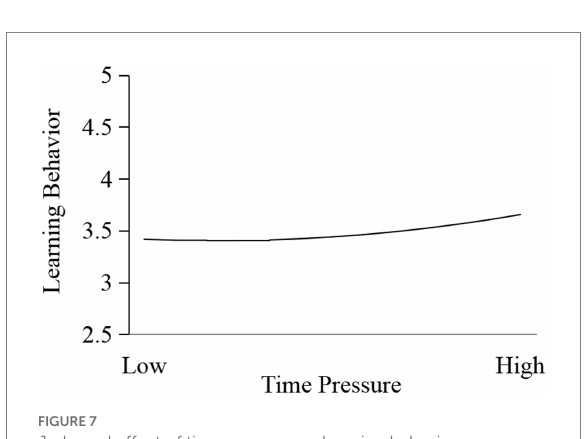
FIGURE 7 J-shaped effect of time pressure on learning behavior.